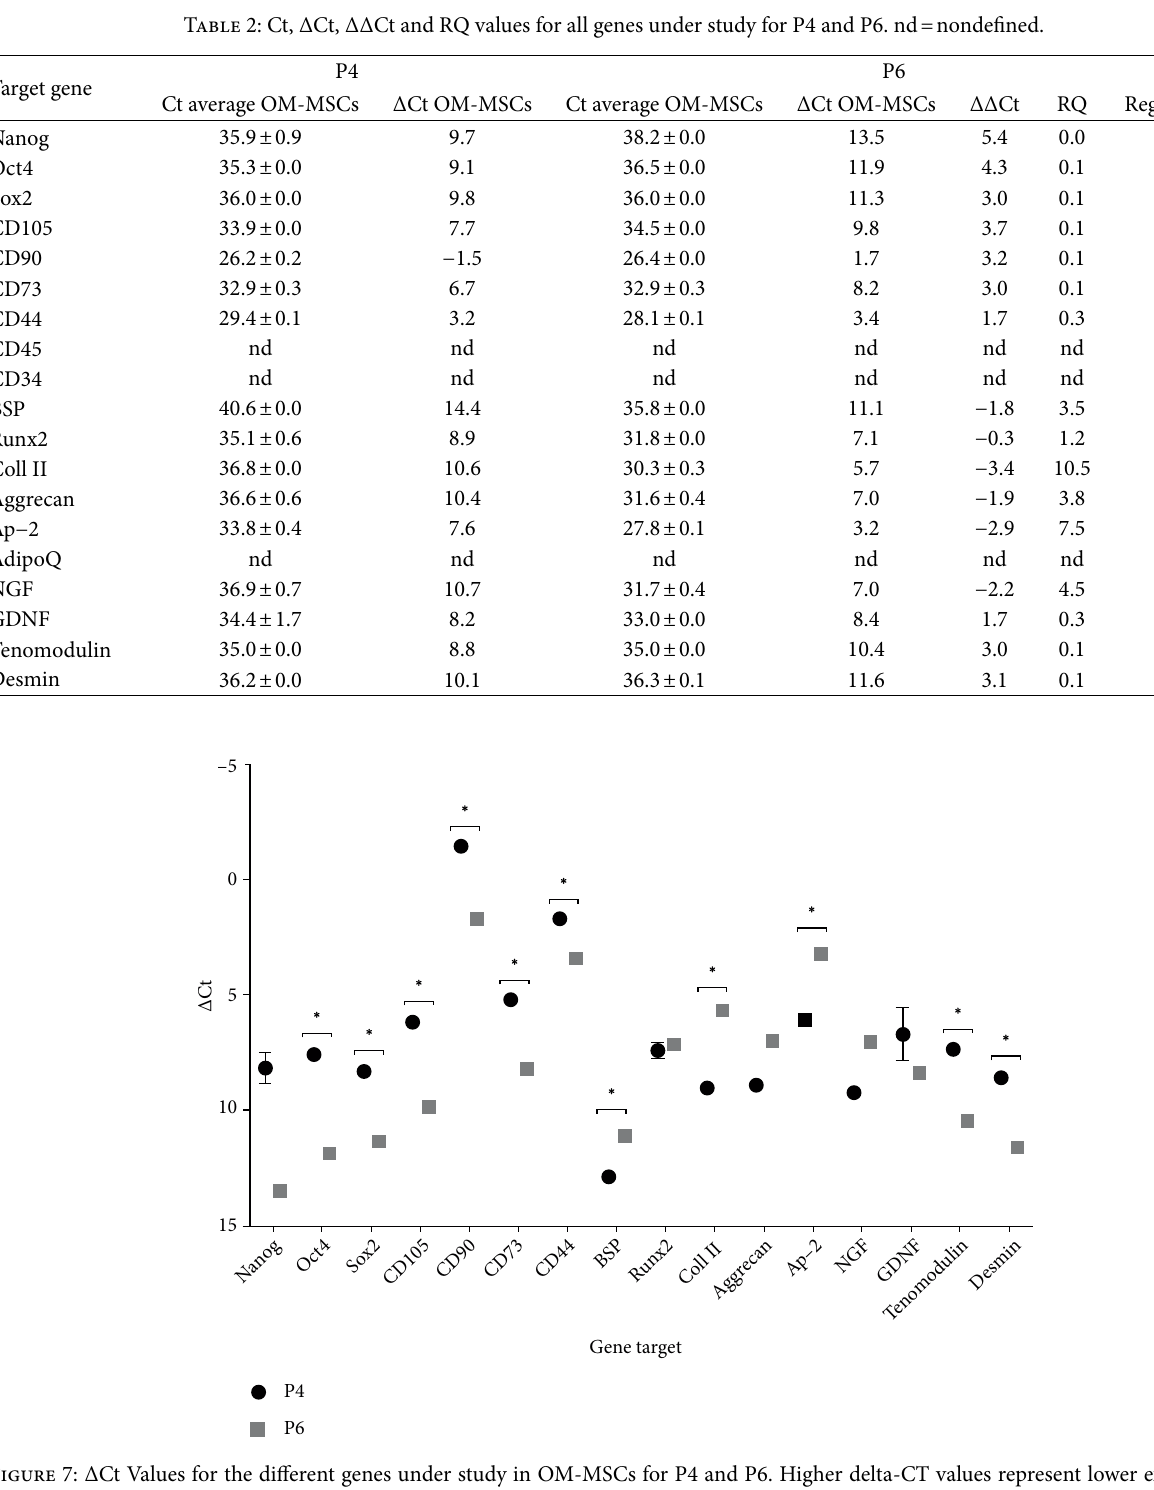
Figure 7: ΔCt Values for the different genes under study in OM-MSCs for P4 and P6. Higher delta-CT values represent lower expression (mean ±